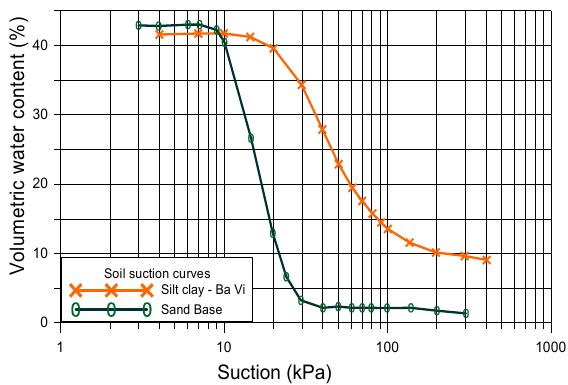
Figure 2. Soil–water characteristic curves.